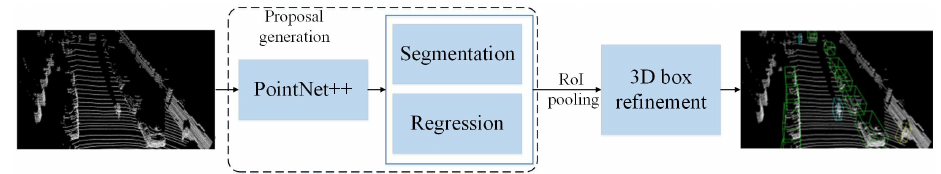
Figure 11. Architecture of